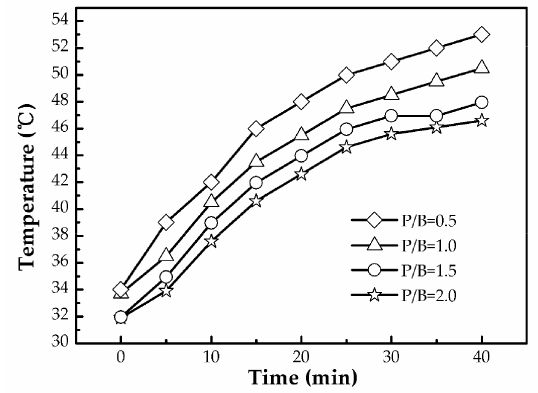
Figure 5. The surface temperature of polysiloxane/Al coatings under continuous IR